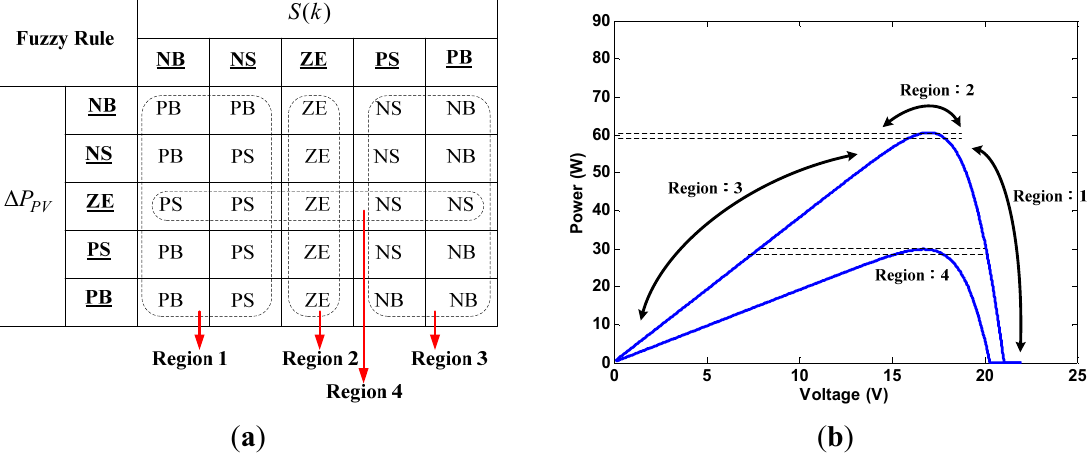
Algorithm (ii): P-V Slope and Variation of Power as the Inputs Algorithm (ii) of the fuzzy logic MPPT system used the slope